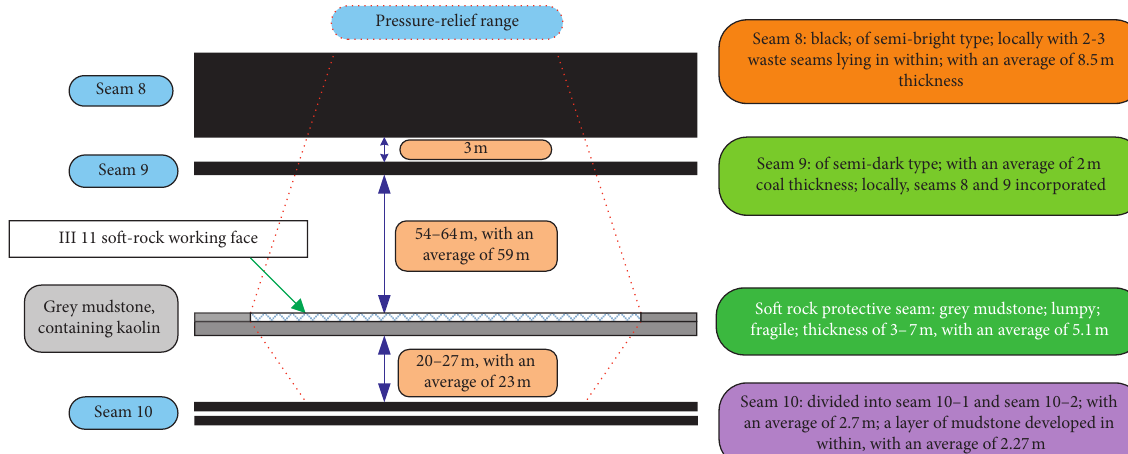
Figure 17: Selection diagram of soft-rock protective seam in III1 mining